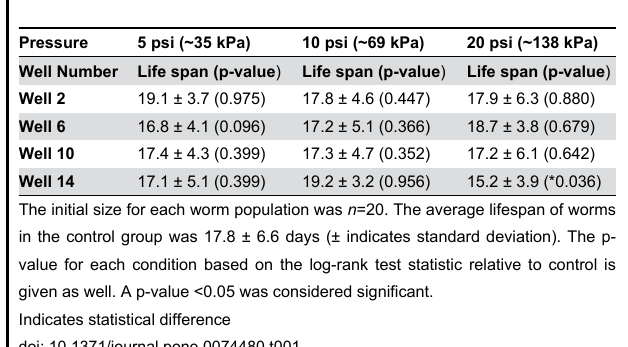
Table 1. Average animal lifespan (days) after delivery through the whole chip under different pressure conditions.